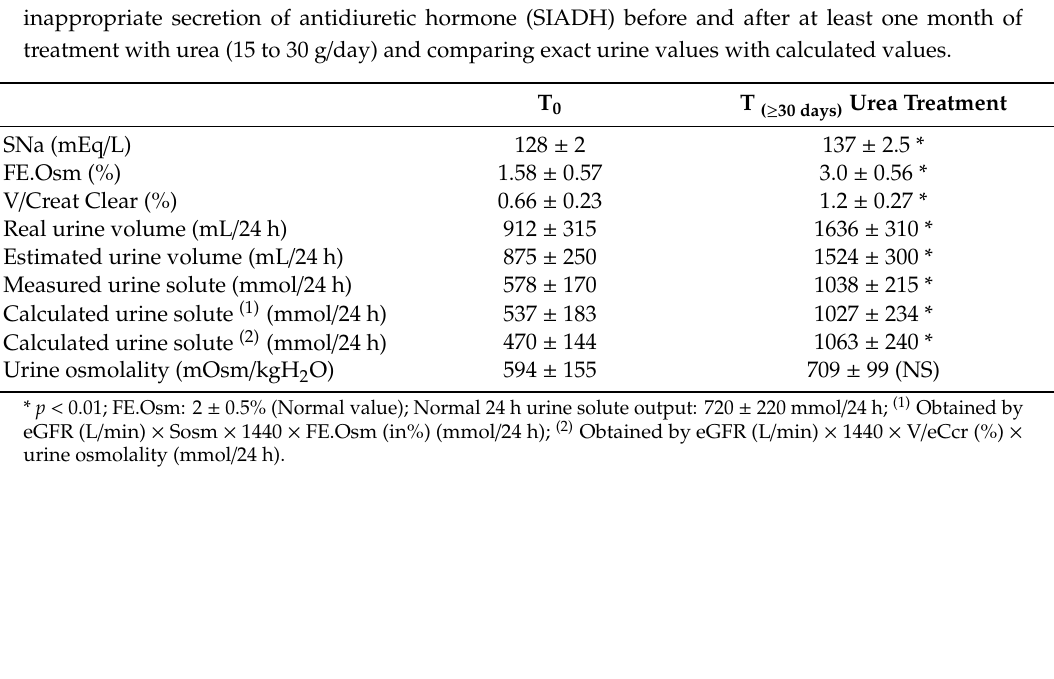
Table 3. Some biochemical parameters in six patients with chronic hyponatremia secondary to the inappropriate secretion of antidiuretic hormone (SIADH) before and after at least one month of treatment with urea (15 to 30 g / day) and comparing exact urine values with calculated values. Urea Treatment T 0 T ( ≥ 30 days) SNa (mEq / L) 128 ± 2